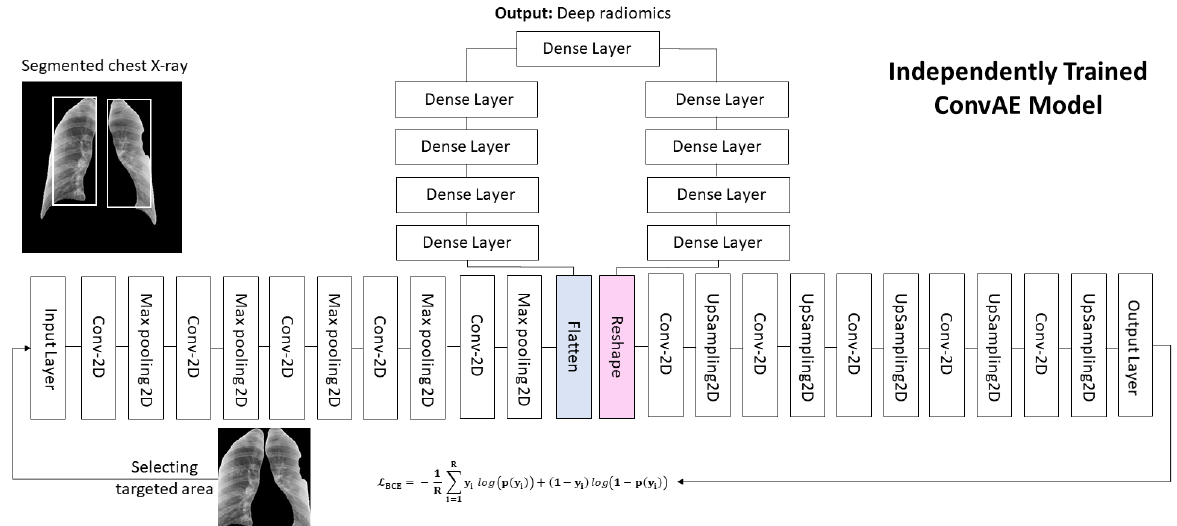
Figure 2. The proposed convolutional deep autoencoder (ConvAE) for generating deep radiomics with low-dimensional deep radiomic descriptors.